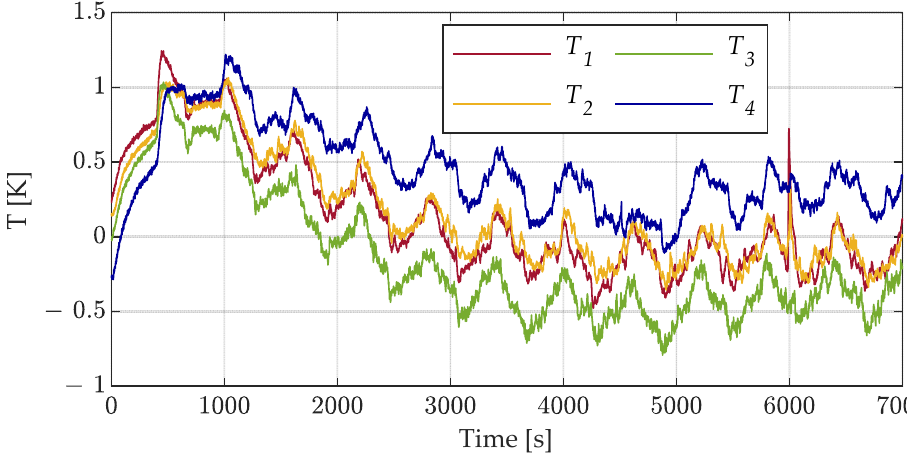
Figure 16. Error test single cell 20 A.